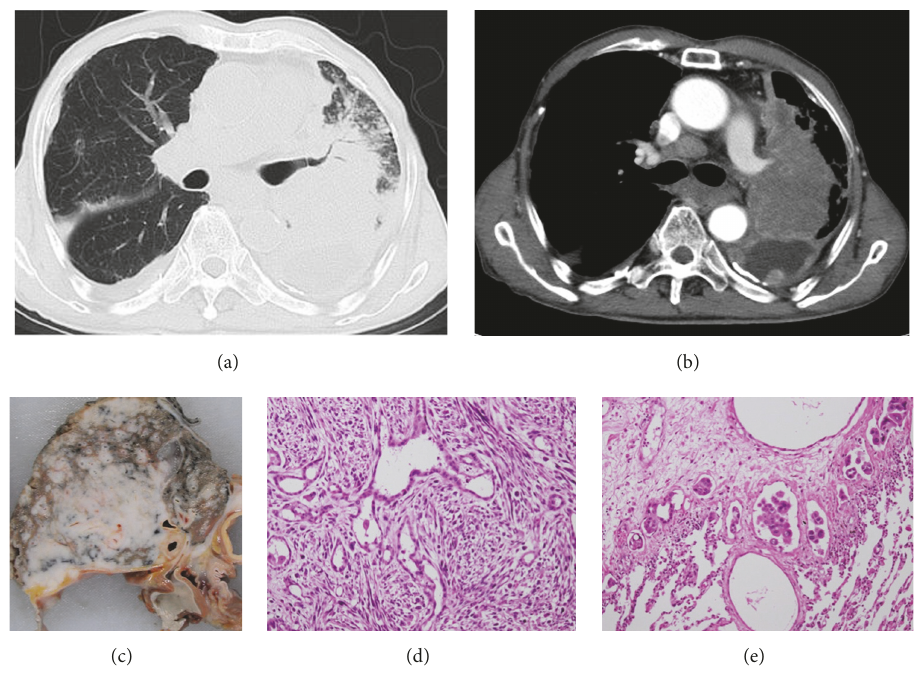
Figure 2: (a) An axial chest CT scan showed extensive bronchovascular bundle and septal thickening, an upper lobe consolidative mass, and perilymphatic nodules in the left lung; these findings are consistent with the lymphangitic spread of the tumor. (b) A contrast-enhanced chest CT scan showing a left upper lobe consolidative mass, left-sided pleural effusion, and pleural thickening with mediastinal lymph node swelling. (c) The gross pathological findings of the lung and pleura at autopsy. The lung parenchyma is encased by tumor growth and the lymphatic spread of the tumor is observed. (d) A low-power magnification view of the pleural tumor. The tumor is composed of epithelioid and spindle cells (hematoxylin and eosin staining, × 100). (e) Low-power magnification of the pleural tumor. The lesion was histologically diagnosed as biphasic-type malignant pleural mesothelioma. The photomicrograph shows invasion of the lymphatic channels by the tumor (hematoxylin and eosin staining, ×